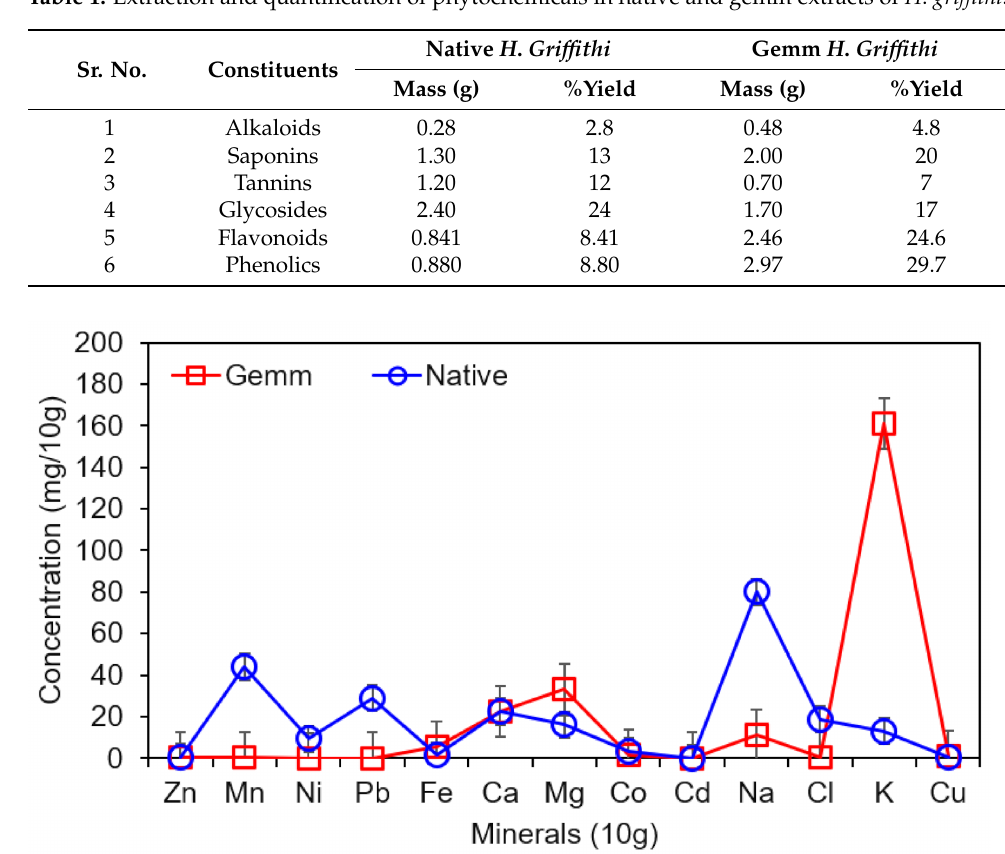
Figure 2. Mineral profile of both Native and gemm extracts of H. griffithi